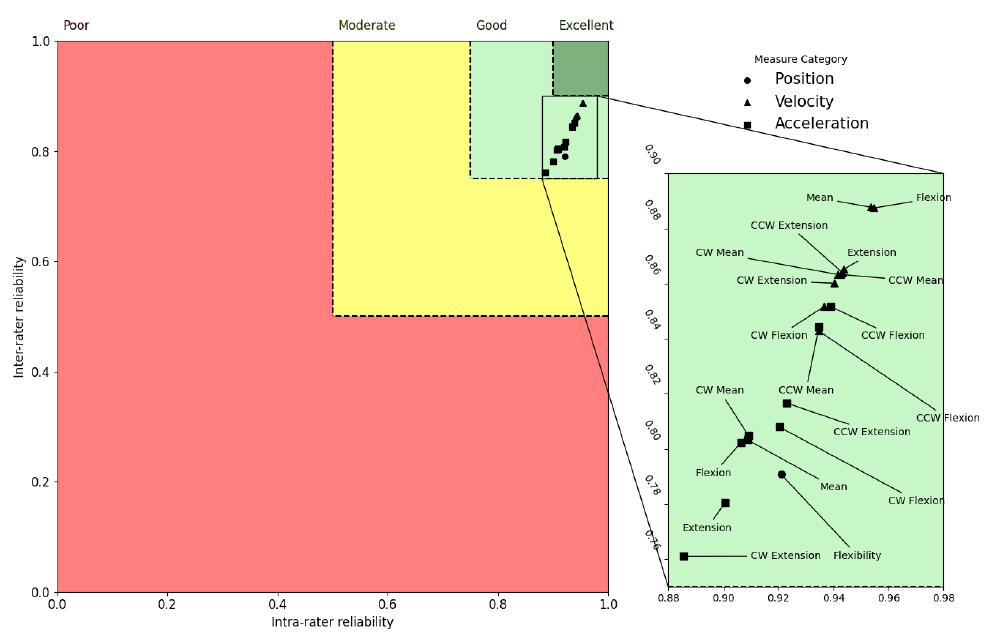
Figure 4. Sagittal plane inter-rater vs. intra-rater reliability. Regions with poor, moderate, good, and excellent reliability are shown, respectively, in red, yellow, light green, and dark green. Circles, tri- angles, and squares are used to represent measures extracted from flexibility, velocity, and acceleration signals,